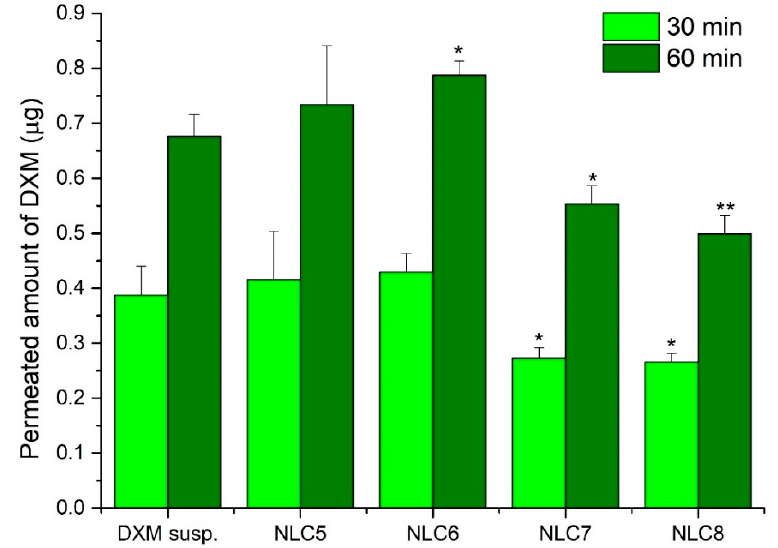
Figure 9. The penetrated amount of DXM through HCE-T cells after 30 min and 60 min. Values are presented as means ± SD. Statistical analysis: ANOVA followed by Dunnett’s test. (* p ≤ 0.05 significant; ** p ≤ 0.01 very significant difference from DXM suspension ( DXM susp.)).